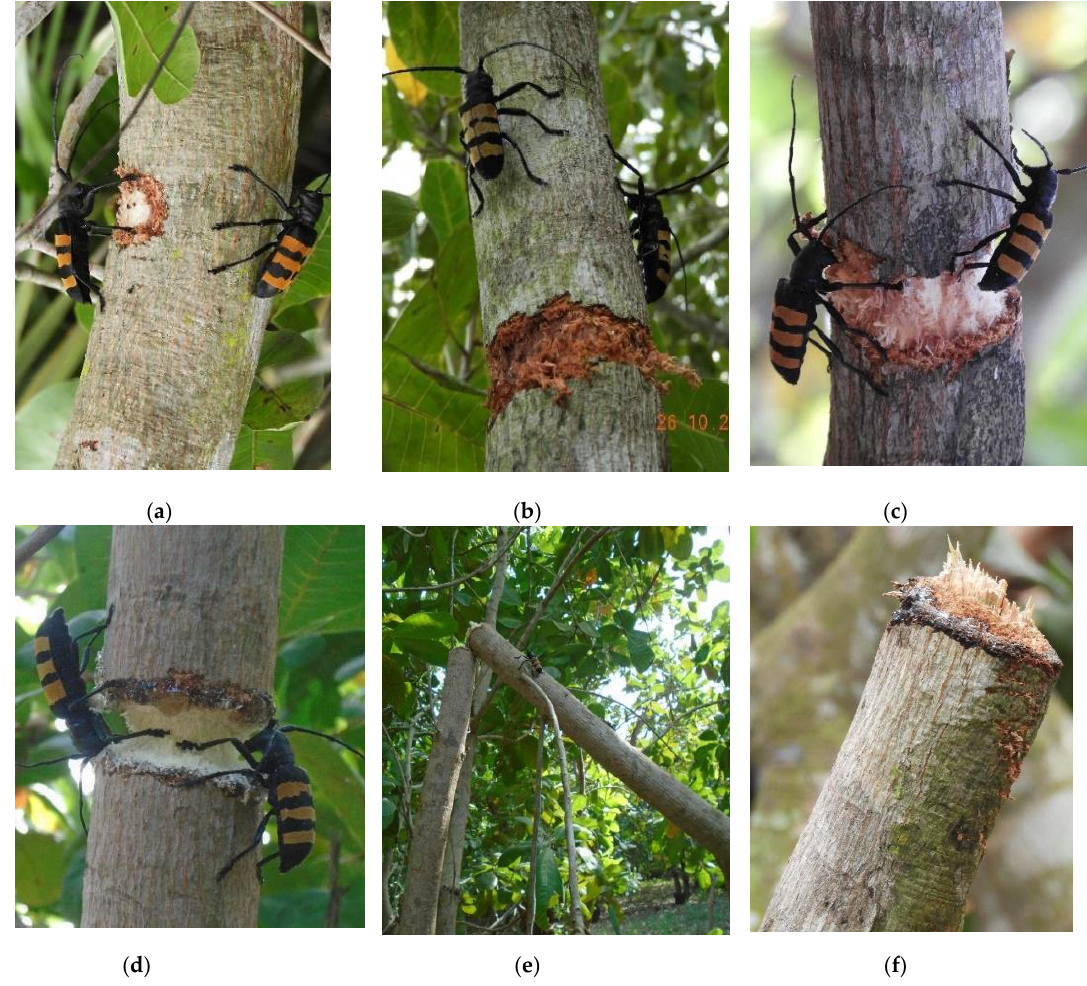
Figure 3. Process of cashew tree branches attack by a couple of Diastocera trifasciata . ( a ) Start of attack at bark level, scale bar 20.4 mm; ( b ) deep attack of the bark, scale bar 18.5 mm; ( c ) attack on sapwood, scale bar 13.8 mm; ( d ) very deep attack, scale bar 16 mm; ( e ) end of attack and breakage of the branch, scale bar 16 mm; ( f ) side view of an attack area on a cut branch, scale bar 17 mm.